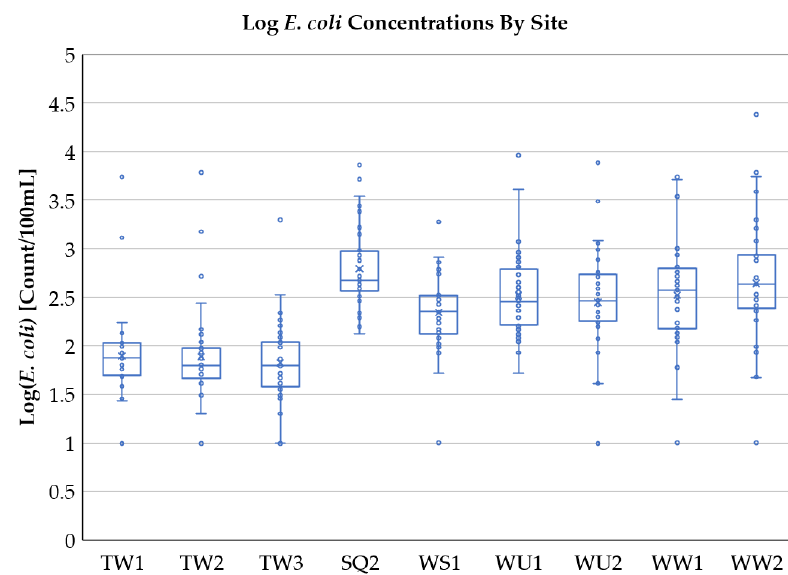
Figure A3. FIB: Box plots for E. coli concentrations based on site.